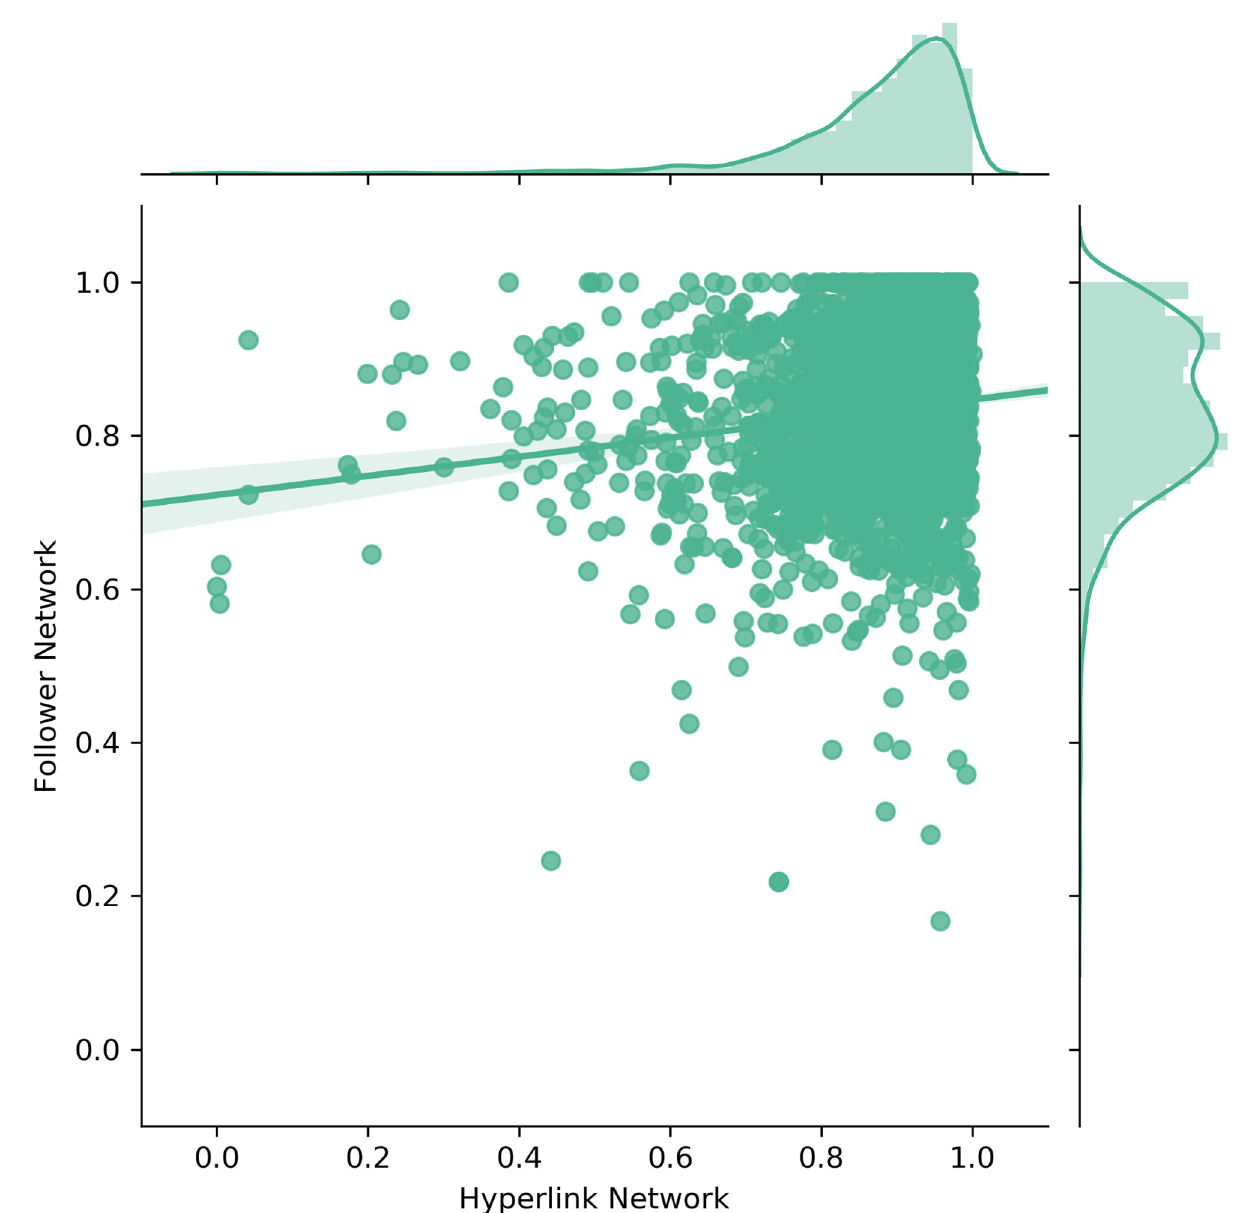
Fig 9. Scatter and density plots for cognitive